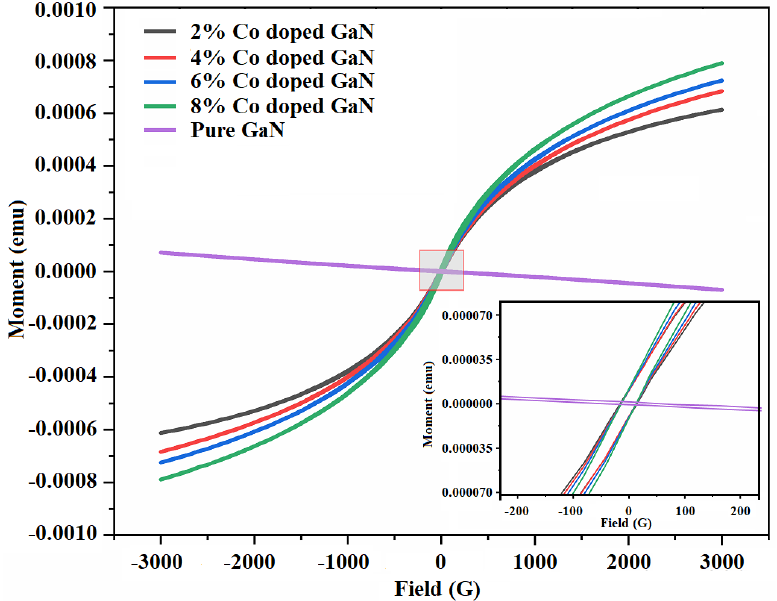
Figure 6. M versus H curves for pure and Co:GNNWs (2%, 4%, 6% and